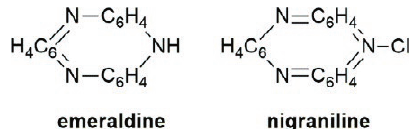
Figure 12. Green’s initially proposed structures of emeraldine and